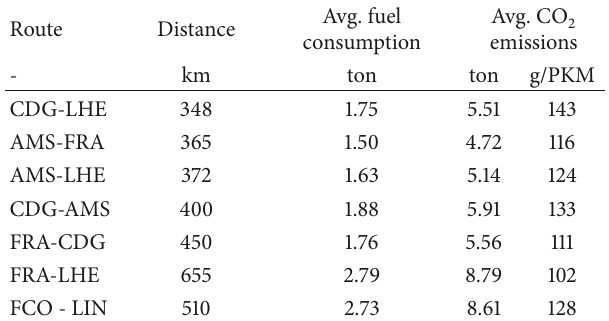
Table 7: Fuel consumption and CO 2 emission per